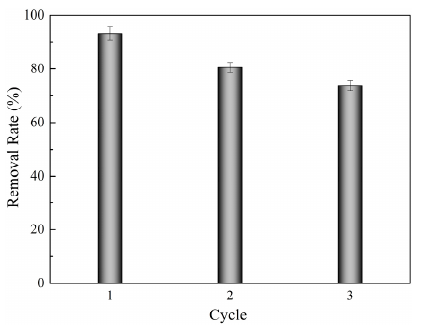
Figure 8. Recyclability of Ag + on TSC-CC resin after three cycles of adsorption/desorption.